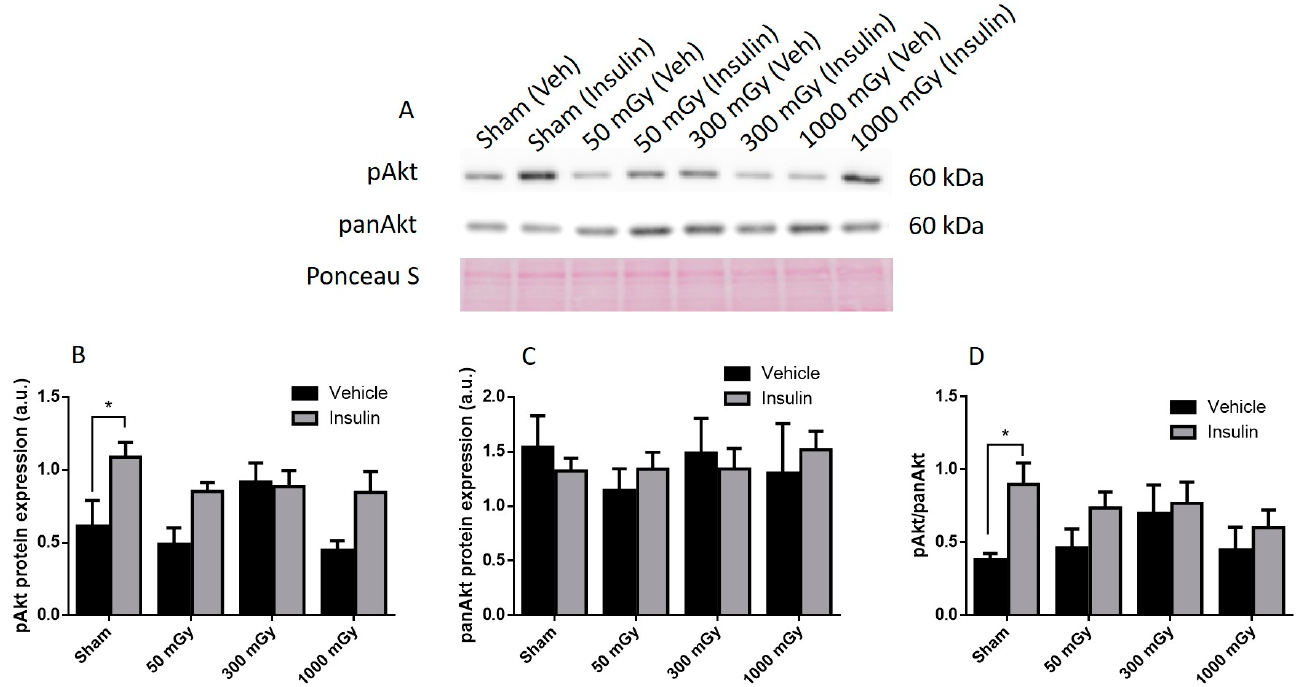
Figure 3. Representative western blot ( A ) and quantified band density (relative protein expression in arbitrary units) for phosphorylated Akt (pAkt) ( B ), Pan Akt (panAkt) ( C ), and the ratio of phosphorylated protein to total protein ( D ) in hearts of male offspring. Results were normalized to loading controls (samples repeated on each gel) to account for differences between gels and Ponceau S staining was used as a marker of equal protein loading. Data are presented as mean ± SEM. *, denotes significantly different between vehicle and insulin injection, and p ≤ 0.05. n = 11–13 per group.